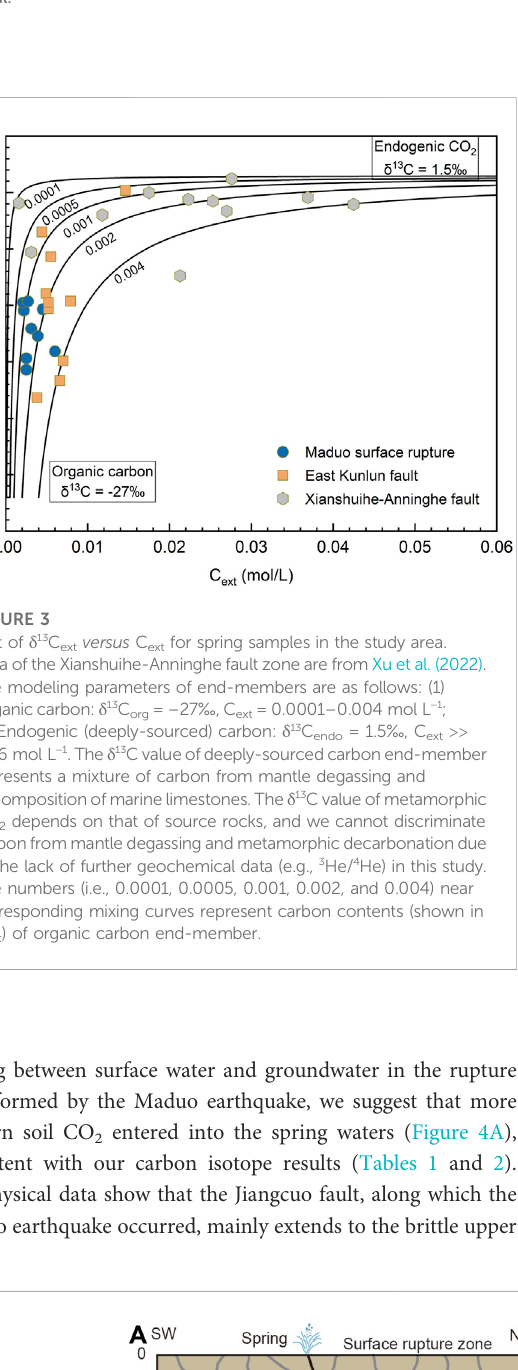
Frontiers in Earth